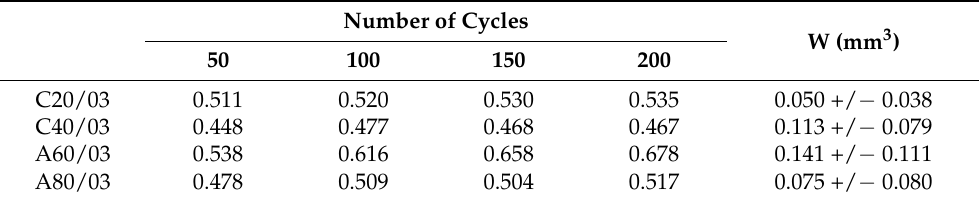
Table 7. COF for brake pads prepared with the same concentration of ELT rubber particles and different particle size at different brake cycles and the corresponding wear rate value (W) at the end of the